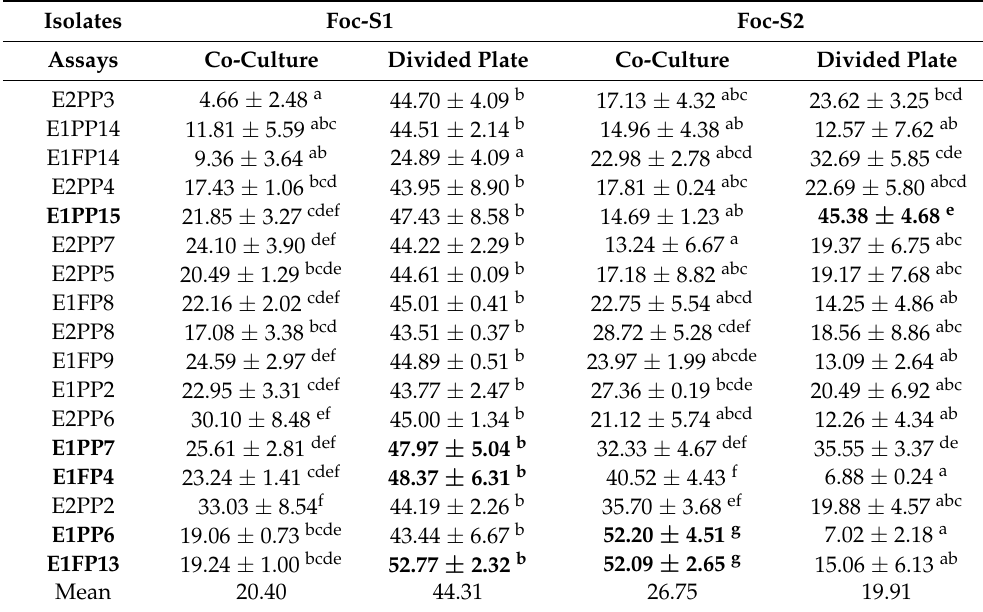
Table 1. Percentages of inhibition of Foc radial growth by antagonistic Pseudomonas isolates in each assay. Isolates Foc-S1 Foc-S2 Assays Co-Culture Divided Plate Co-Culture Divided